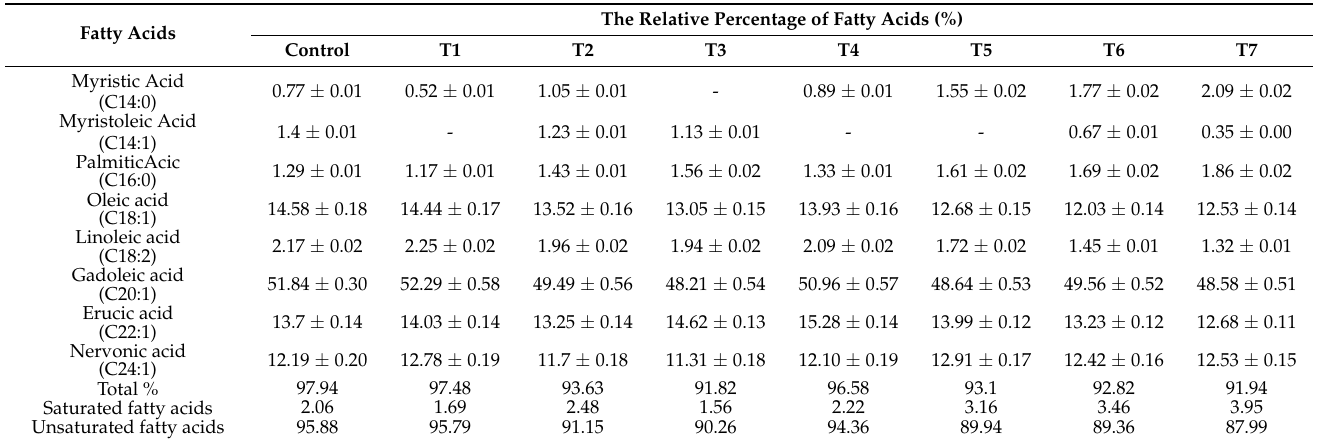
Table 10. The relative percentage of fatty acids (%) of fixed oil of Jojoba oil affected with combination treatments of ground inoculation of Arbuscular mycorrhizal fungi and foliar application of Moringa oleifera leaves extract.